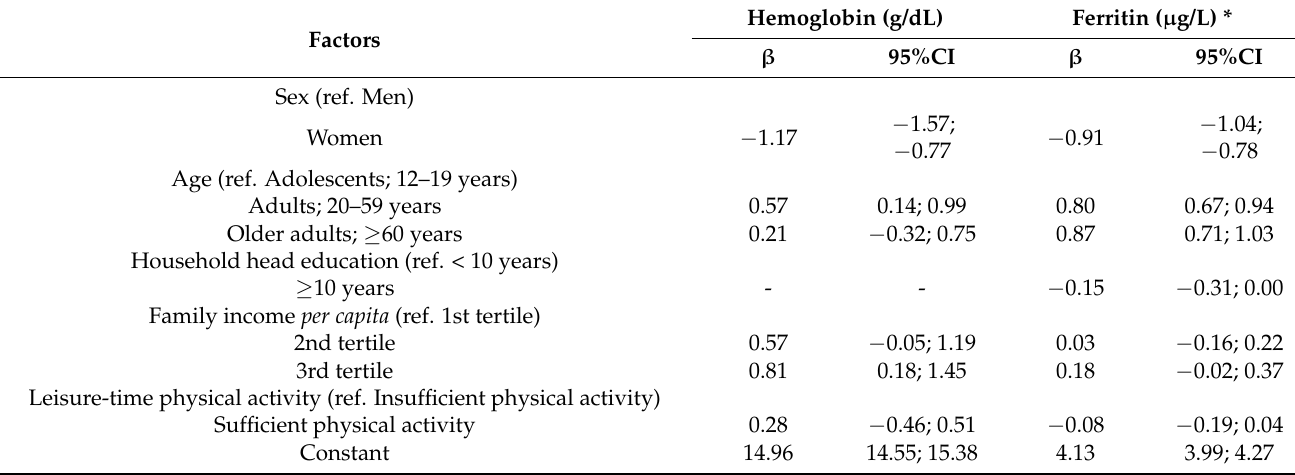
Table 5. Multiple linear regression analysis of hemoglobin and ferritin with iron/anemia blood biomarkers, sociodemo- graphic and lifestyle factors in non-institutionalized residents of the urban area of S ã o Paulo: 2015 Health Survey of S ã o